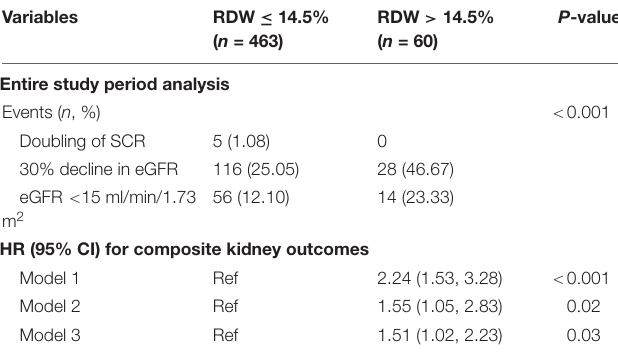
all-cause mortality risk in both hemodialysis (26) and peritoneal